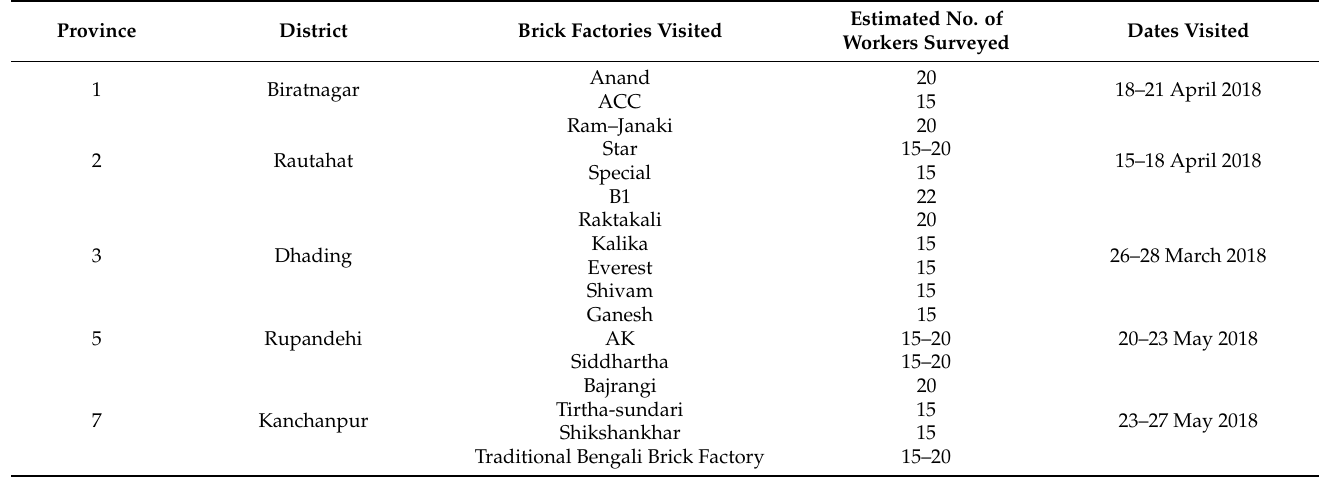
Table 2. Brick factories visited for the